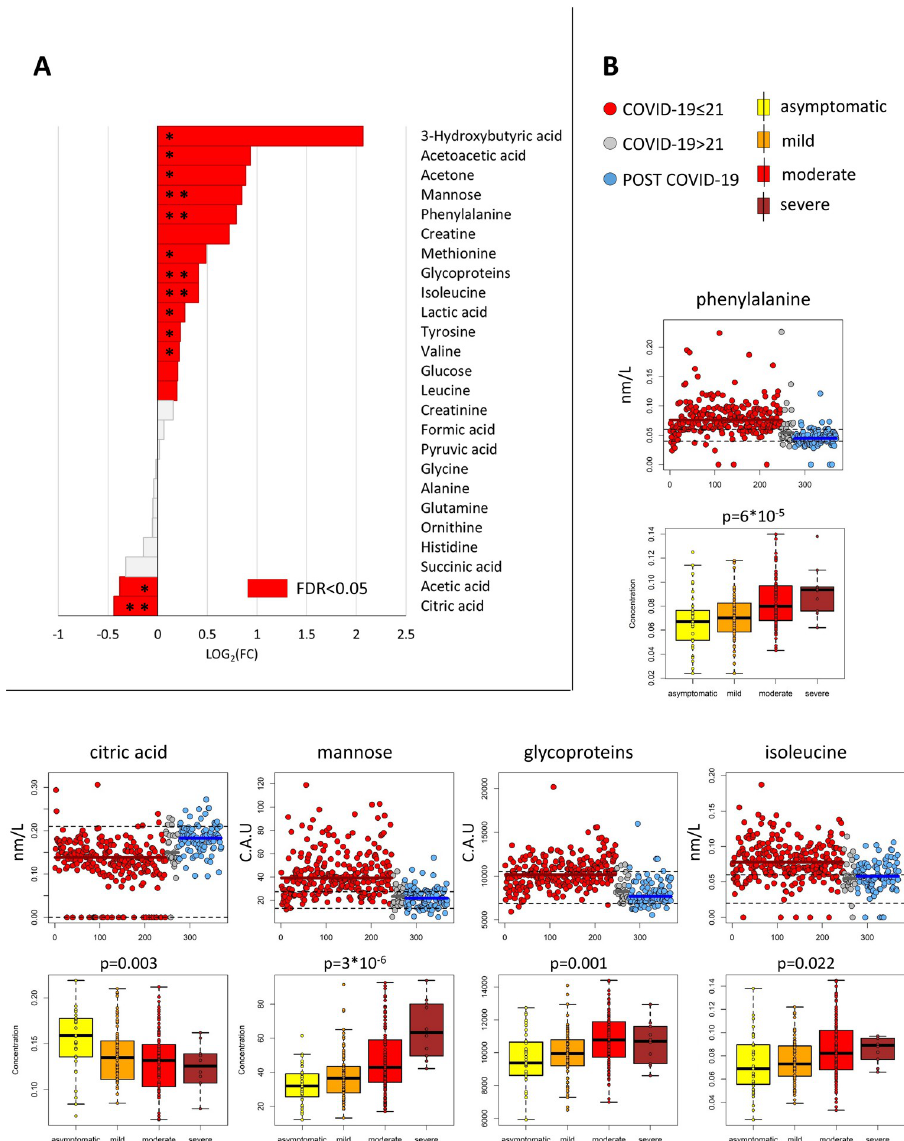
Fig 3. Metabolite profiling. A) Values of Log 2 Fold Change (FC) of quantified metabolites. Positive/negative values, have higher/lower concentration in serum samples from COVID-19 � 21 patients with respect to Post COVID-19 subjects. Red bars refer to significantly different metabolites (p-value (FDR) < 0.05); Cliff’s delta effect size are also reported: �� large, � medium. B) Upper panels: Scatter plots of concentration levels for significant metabolites (p-value (FDR) � 0.05) with a “large” Cliff’s delta effect-size for the comparison COVID-19 � 21 vs. Post COVID-19 groups; red dots represent COVID-19 � 21 subjects, grey dots refer to COVID-19 > 21 subjects and blue dots to Post COVID-19 individuals; the median of each group is represented as a colored line; black dashed lines embrace the concentration ranges in a “healthy” population. Lower panels: boxplot of the concentration levels of COVID-19 � 21 samples according to the grade of severity, i.e. asymptomatic (yellow), mild (orange), moderate (red), severe (brown).